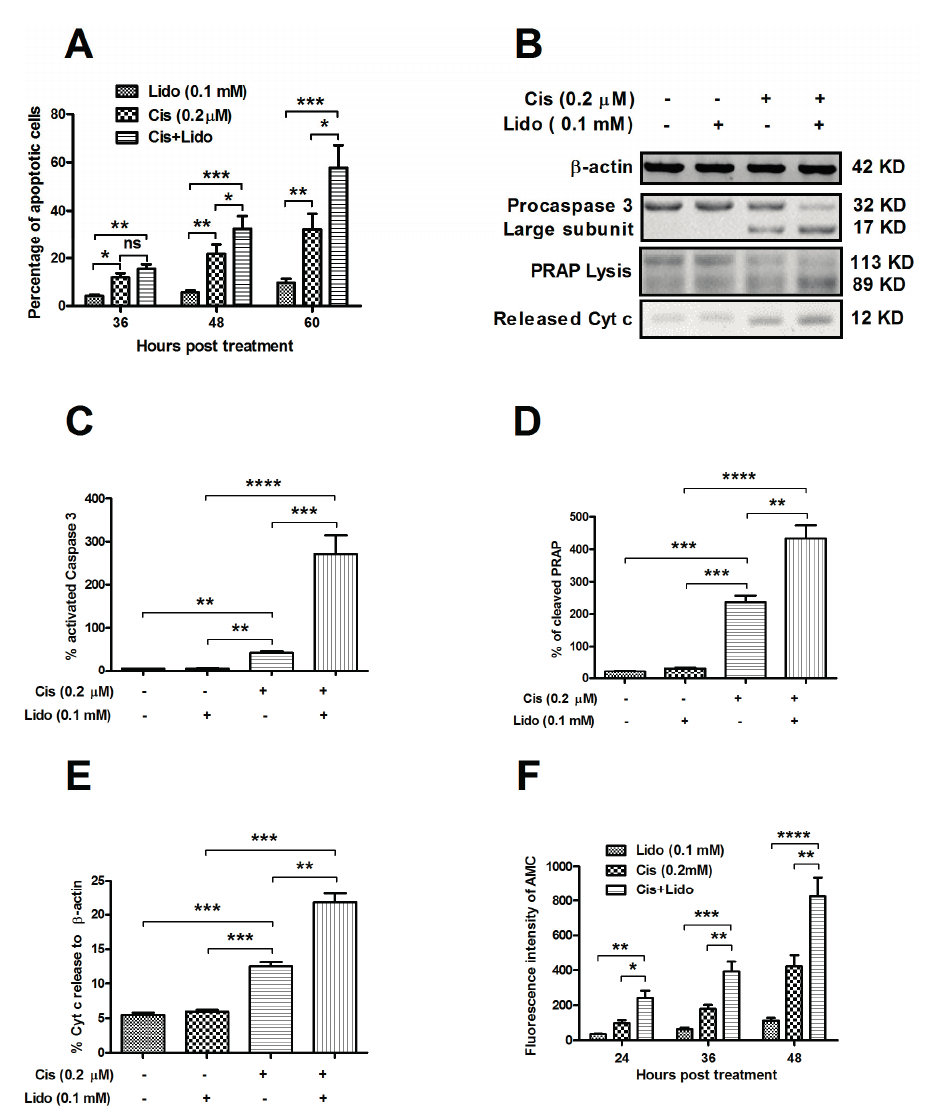
Figure 5. Lidocaine enhances cisplatin-induced apoptosis in MCF-7 cells. ( A ) Apoptotic cells induced by 0.2 μ M cisplatin, or (and) 0.1 mM lidocaine for 36, 48 or 60 h; ( B ) Western blot analysis of activated caspase 3, cleaved PARP by activated caspase 3 and cytochrome c released from mitochondria in MCF-7 cells treated with 0.2 μ M cisplatin, and/or 0.1 mM lidocaine for 60 h; ( C – E ) Relative levels of activated caspase 3, PARP cleavage and cytochrome c release to β -actin in MCF-7 cells treated with lidocaine, with cisplatin or with both agents; ( F ) Caspase 3 activity in lidocaine-, cisplatin- or both agents-treated MCF-7 cells, revealing by AMC Caspase Profiling Kit. Each value was averaged for three independent experiment results, and statistical significance was considered when p ˂ 0.05 or less, * p ˂ 0.05, ** p ˂ 0.01, *** p ˂ 0.001, **** p ˂ 0.0001, ns: no